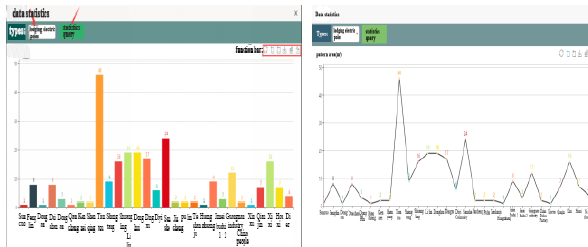
Figure 6. The data statistics histogram of lodging electric poles Figure 7. The line graph interface of the lodging electric poles